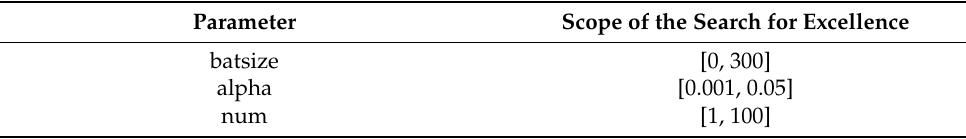
Table 2. BiGRU Hyperparameter Optimization